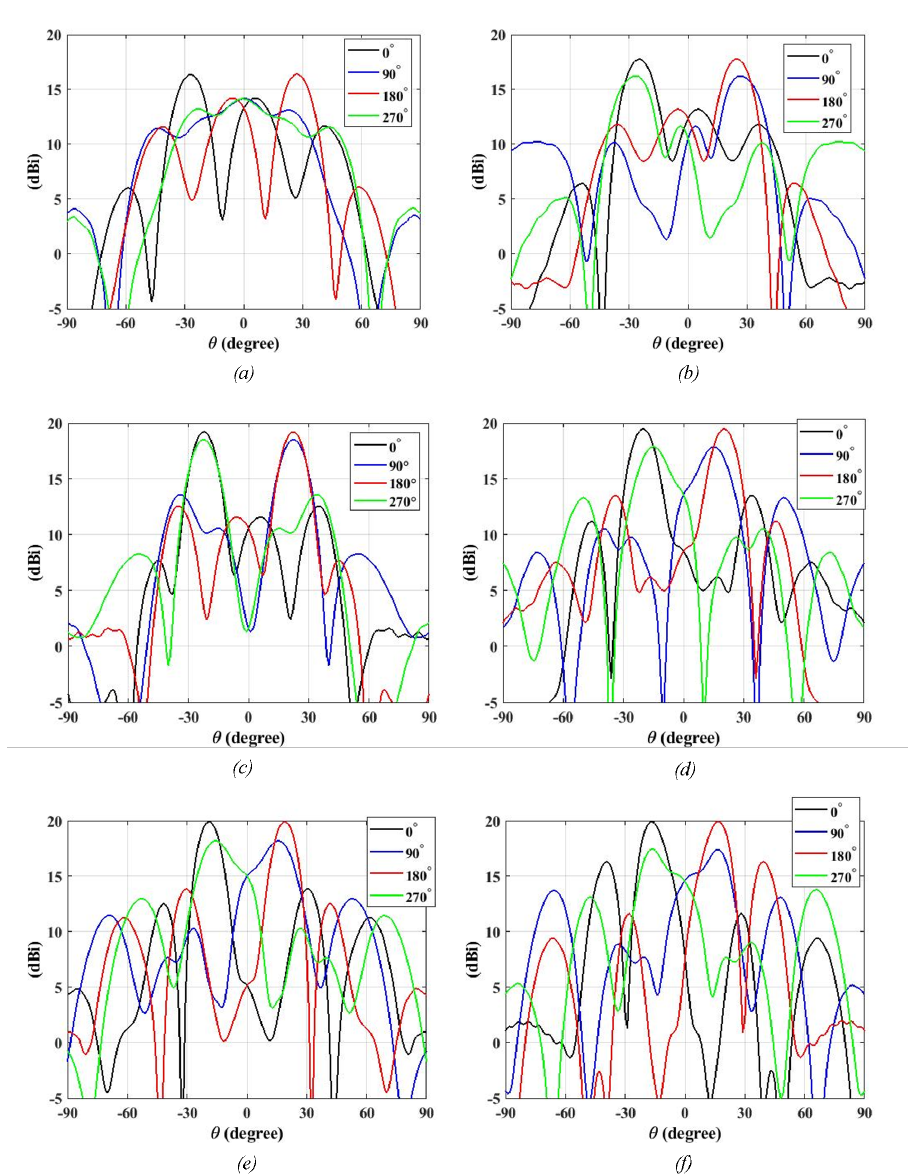
Figure 14. Simulated E-field radiation patterns as observed with the use of the BDS prototype kept above the feed horn: ( a ) 10, ( b ), 11 ( c ), 12 ( d ), 13 ( e ), 14, ( f ) 15